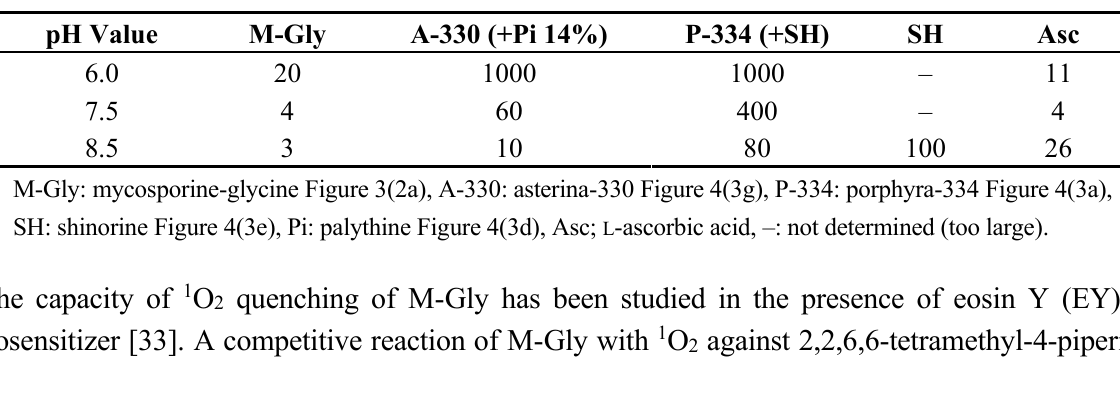
Table 1. pH dependence of IC 50 values on ABTS radical scavenging by various MAAs.